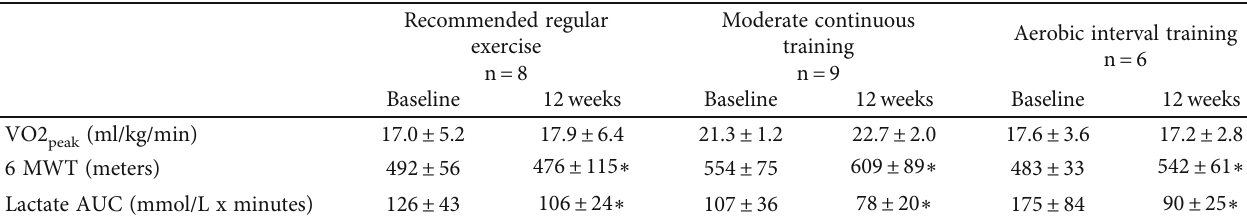
Table 3: Comparisons of training e ff ect in two supervised intervention groups and